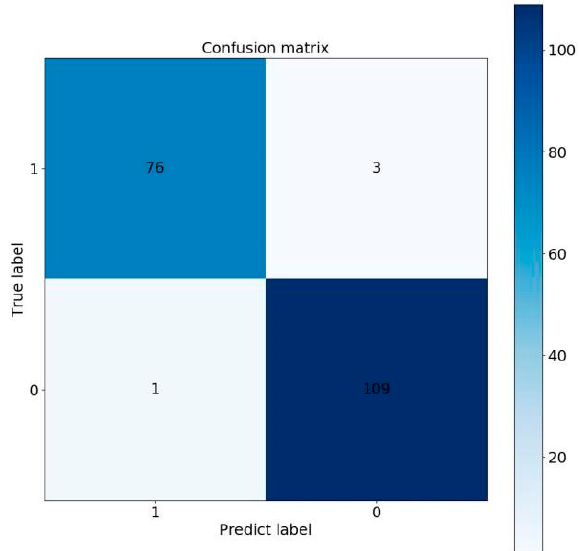
Figure 11. Confusion matrix of the model.